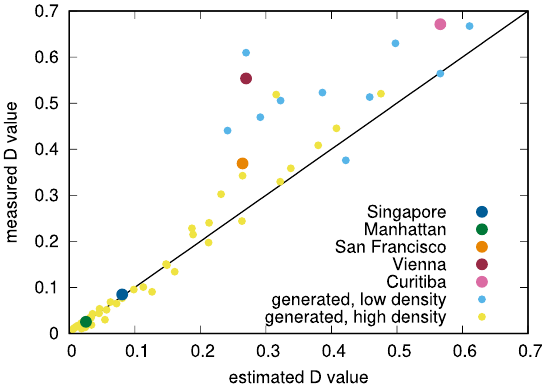
Figure 4. D coefficients according to our simulation results and the empirical model from Eq.